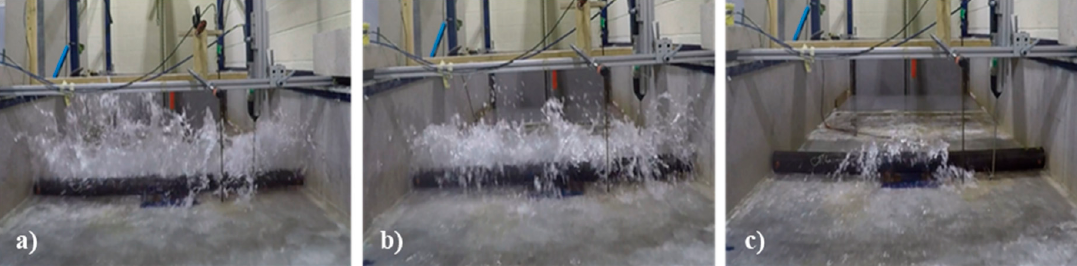
Figure 7. Bore impact on the pipe for three impoundment depths: ( a ) h = 50 cm, ( b ) h = 40 cm, and ( c ) h = 30 cm.